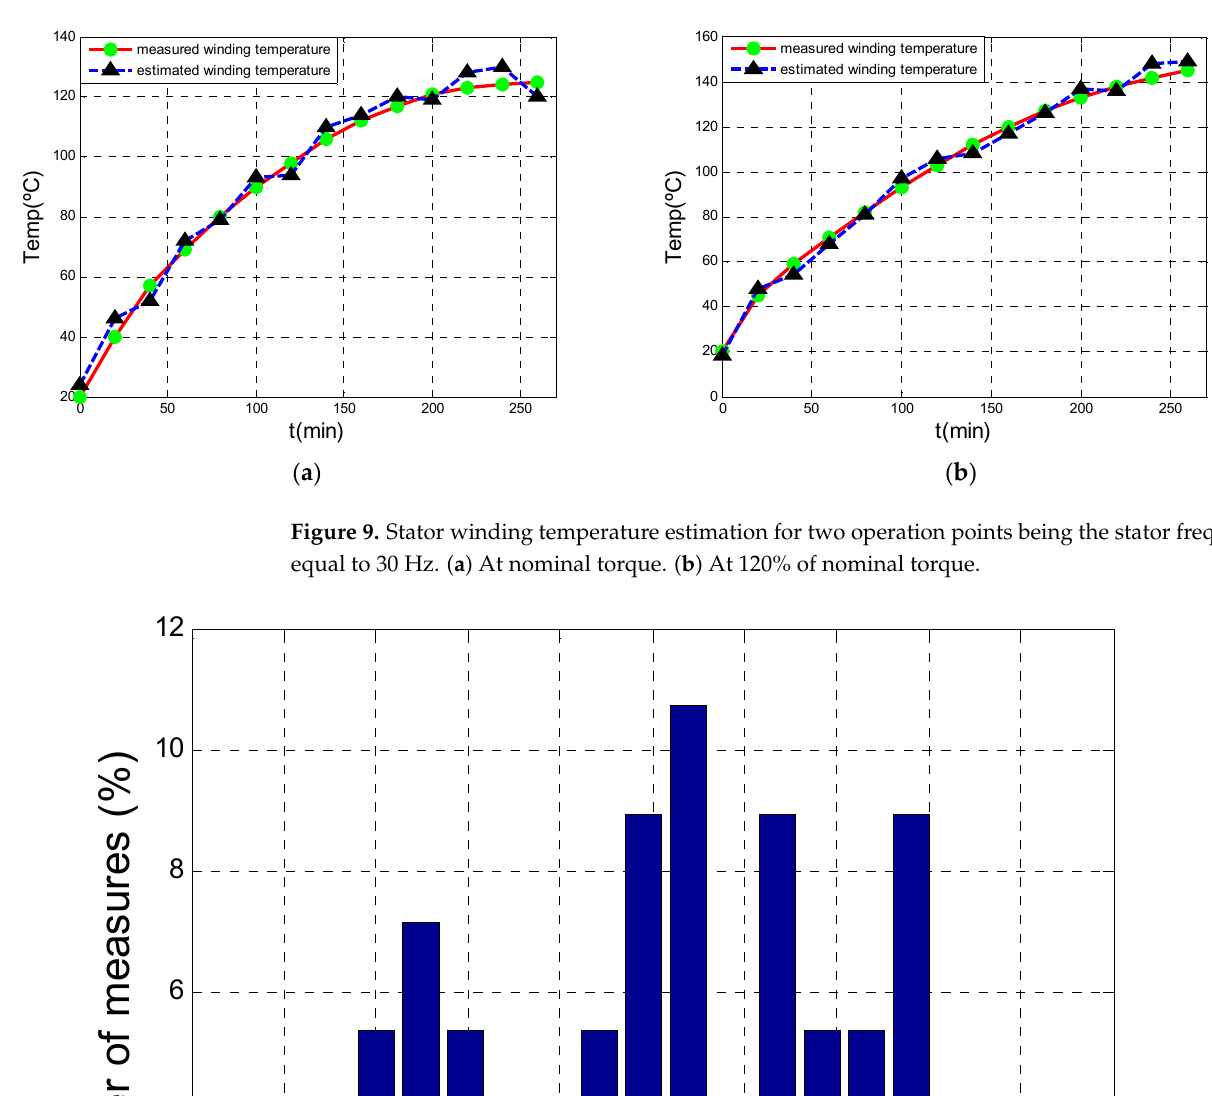
Figure 8. Stator current signal during the injection.